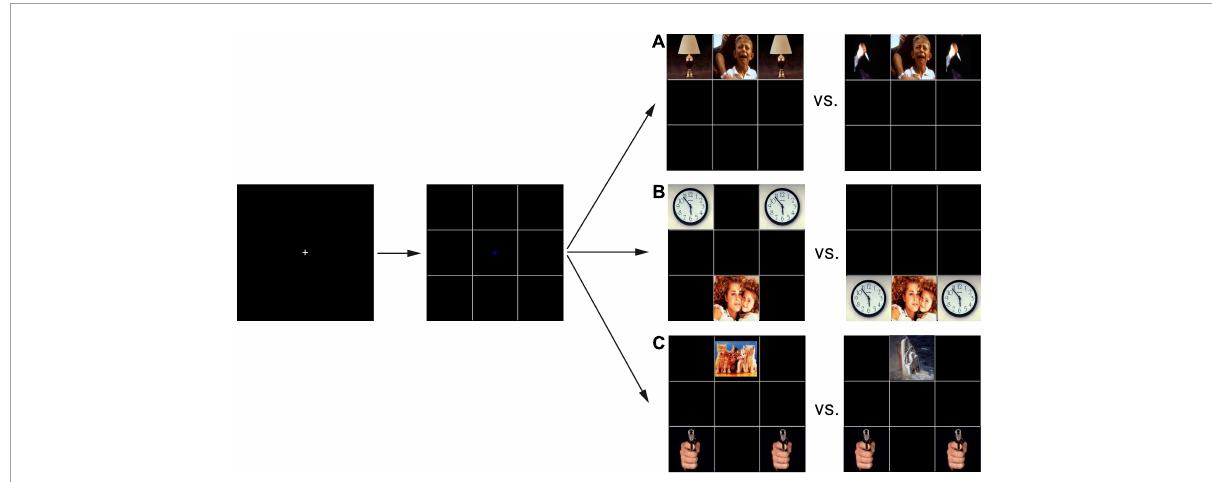
FIGURE2 Visual stimulus of the emotional distractor task. Depicted here is an example of a typical trial. Participants view a fixation cross which is then replaced by a second fixation cross in a 9-panel grid. Both the target picture and the distractors subsequently appear, prompting participants to indicate the target picture location, while ignoring distracting flanker pictures. The different conditions of this panel are shown: flankers were neutral or negative (A) and incongruent or congruent to the target pictures (B) ; targets were either positively or negatively valenced (C) . Target location was either above or below the previously shown fixation cross. Ms, milliseconds. Images are from The International Affective Picture System